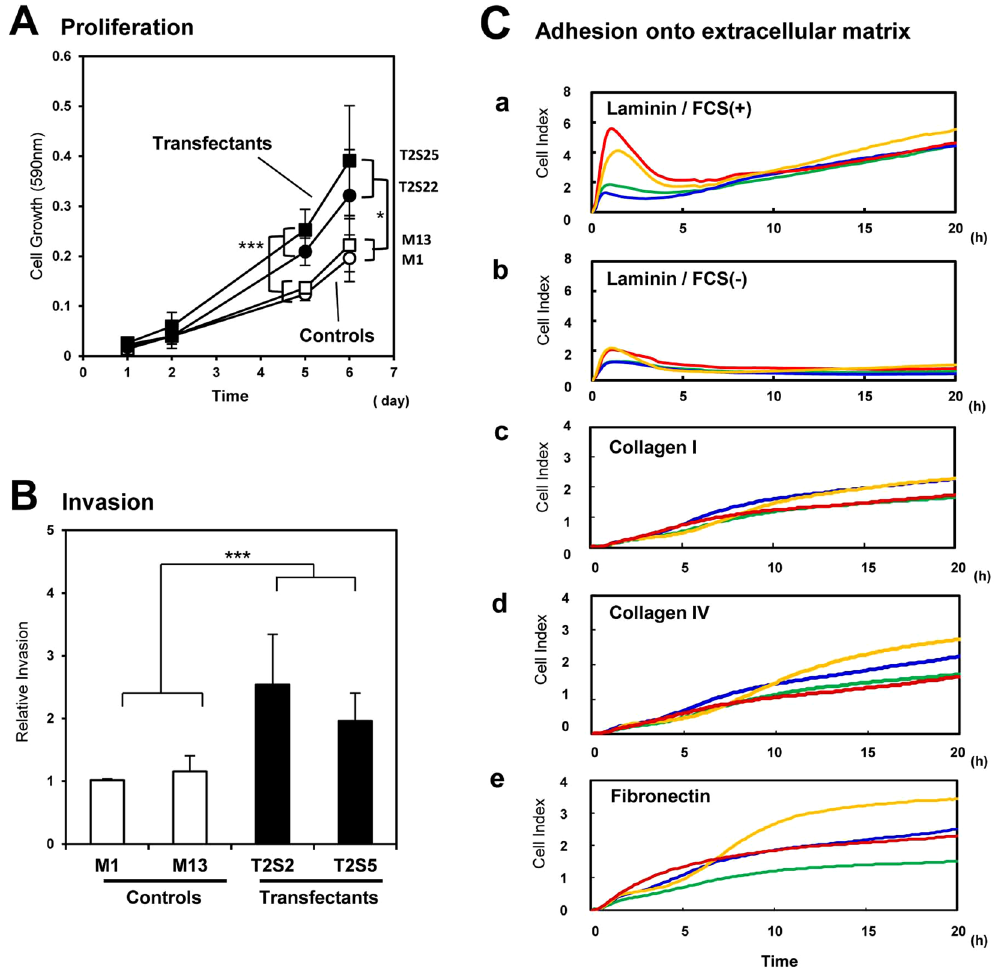
Figure 2. Malignant phenotypes of the B4GalNAc-T2 gene transfectant cells. ( A ) Effects of GalNAc-DSLc4 expression on the cell proliferation. Two transfectants and two vector controls (2.5 × 10 3 cells/well) were seeded in 48-well plates in serum-containing medium and cultured for 6 days. The absorbance (590 nm) was measured on day 1, 2, 5, and 6. Data are means of three independent experiments. ( B ) Invasion activity of two transfectants and two vector controls. Cell invasion was analyzed by Boyden chamber invasion assay by counting the cell number on the reverse side of the filter. Data are means of three independent experiments. Bars indicate mean ± S.D. (n = 3). * P < 0.05, ** P < 0.01, *** P < 0.005. ( C ) Dynamic monitoring of cell adhesion to LN, CL type I, CL type IV, or FN-coated surfaces. GalNAc-DSLc4-expressing cells and control cells were seeded in the wells of 96-well e-plate at 2.5 × 10 4 cells/well with FCS, and cell attachment and spreading were monitored by RT-CES system. The e-plates were pre-coated with LN ( a ), CL type I ( b ), CL type IV ( c ), or FN ( d ). Red and yellow lines mean transfectant cells, and green and blue lines mean control